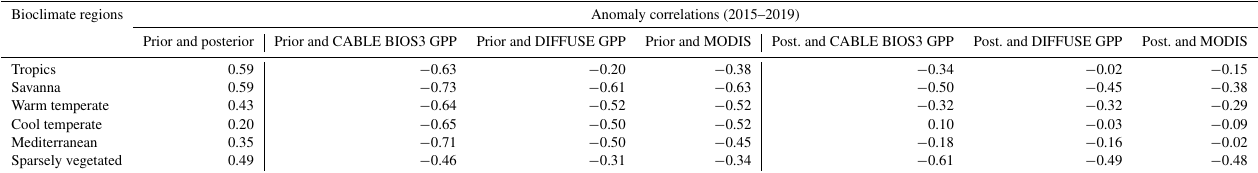
Table H2. The Pearson correlation ( R ) values of prior and posterior flux anomalies with GPP anomalies derived from the respective CABLE BIOS3, MODIS, and DIFFUSE